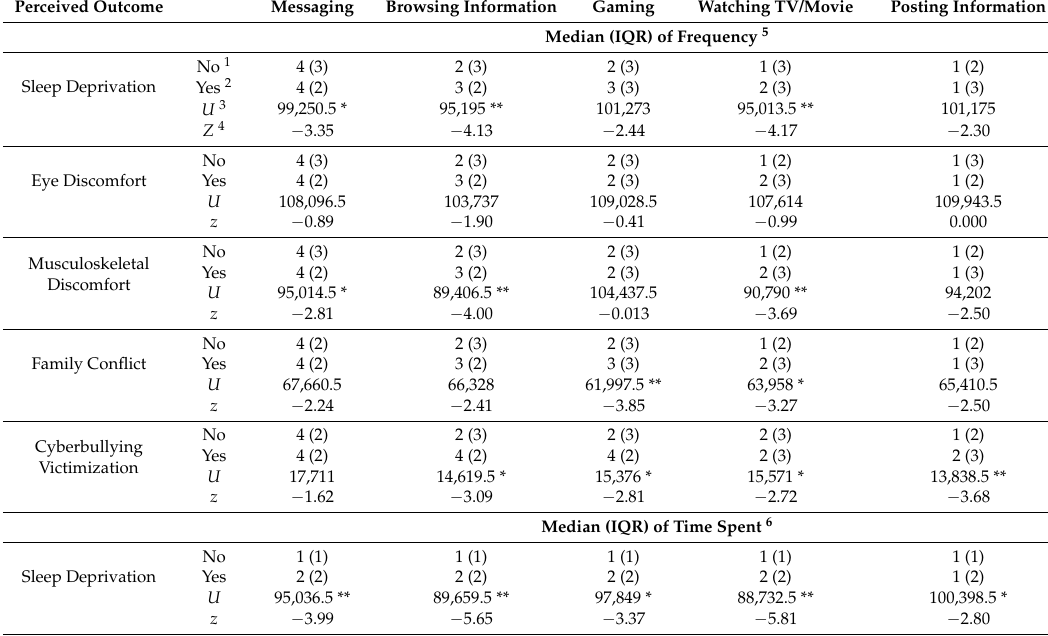
Table 6. Medians and interquartile ranges (IQR) of patterns of smart device activities and pattern differences between adolescents who did and did not perceive the